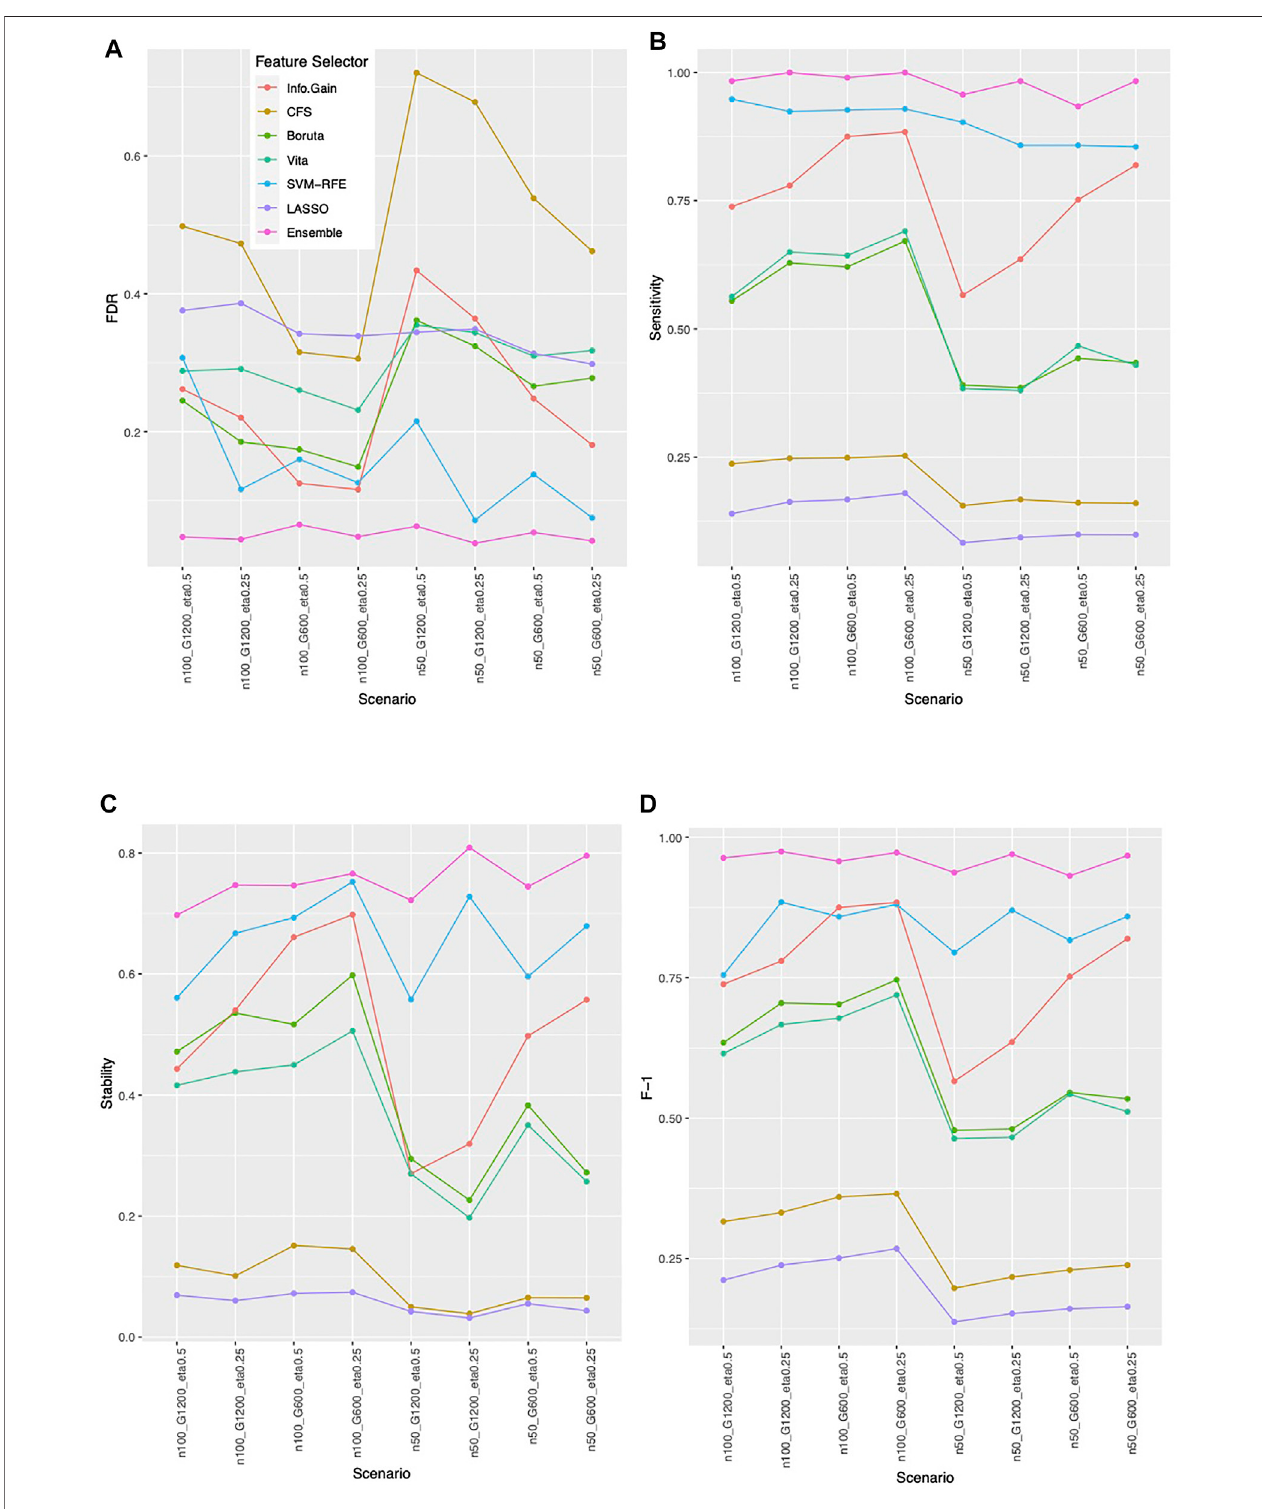
FIGURE 3 | Feature selection performance based on simulation. (A) FDR (B) Sensitivity (C) Stability (D) F-1. In each panel, x-axis stands for different simulation scenariolistedin Table2 .Forexample,n50_G600_eta0.5standsforsamplesizeis50with600candidategenesandtheprobabilityoftheoutcomeis0.5.Eachcolored curve stands for different feature selection